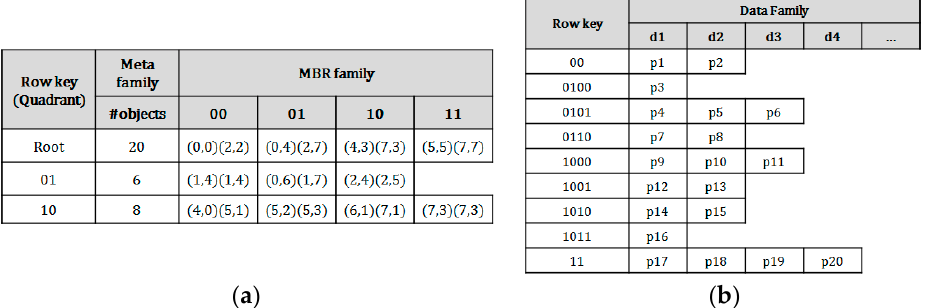
Figure 5. Table schema for a QbMBR tree and data objects: ( a ) An example of a row in a QbMBR tree index table; ( b ) An example of a row in a data table.